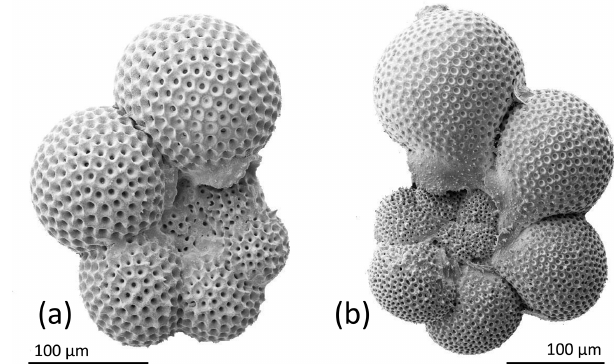
Figure 7. SEM images of Globorotaloides collected during the M74 1b expedition (Bohrmann et al., 2010) in the Arabian Sea, showing shell morphology consistent with the original descrip- tion of (a) Globorotaloides hexagonus (Natland) and (b) Globoro- taloides oveyi (Buckley). Both specimens appeared alive (with coloured cytoplasm) when collected. Specimen in (a) is from sta- tion 947, 300–500m water depth; that in (b) is from station 945, 500–700m water